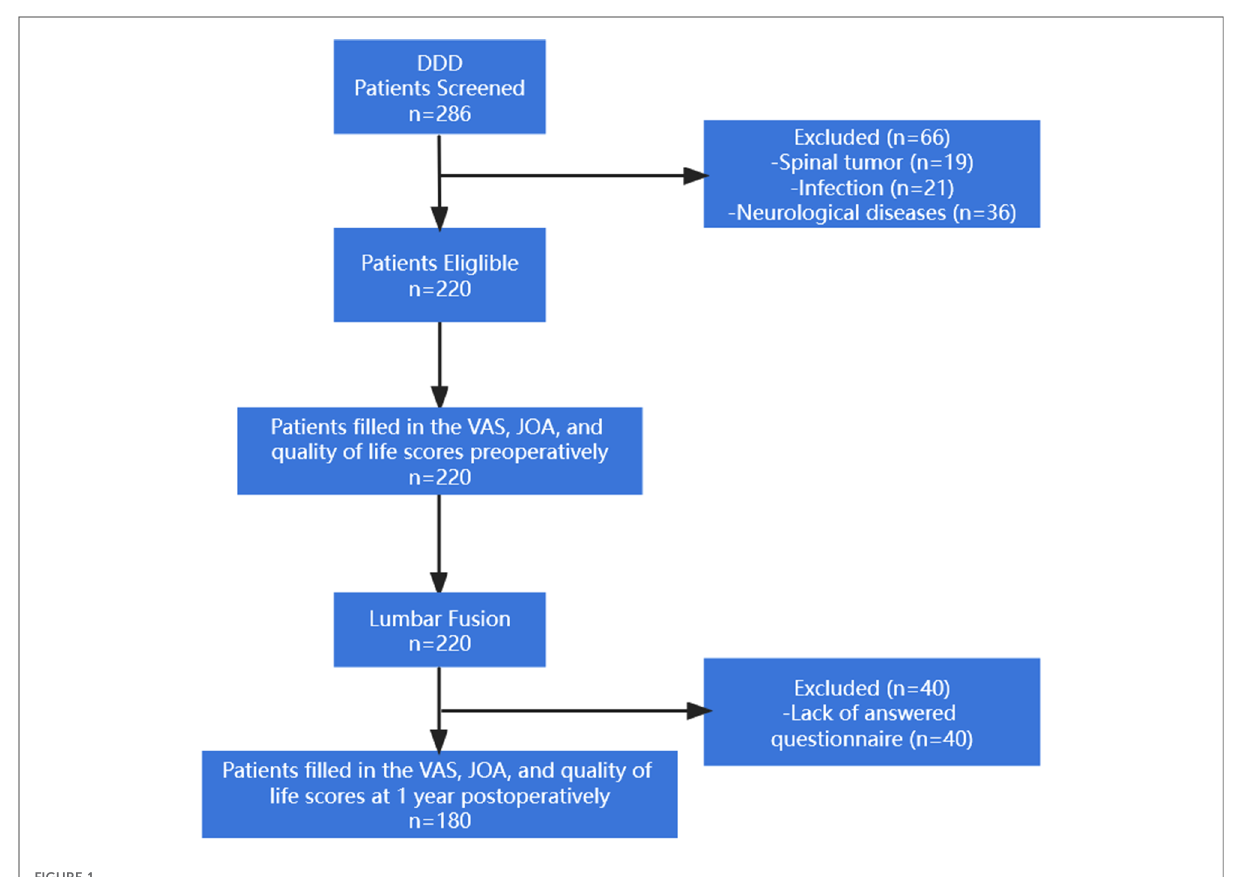
FIGURE 1 Flowchart showing the patient selection process for this